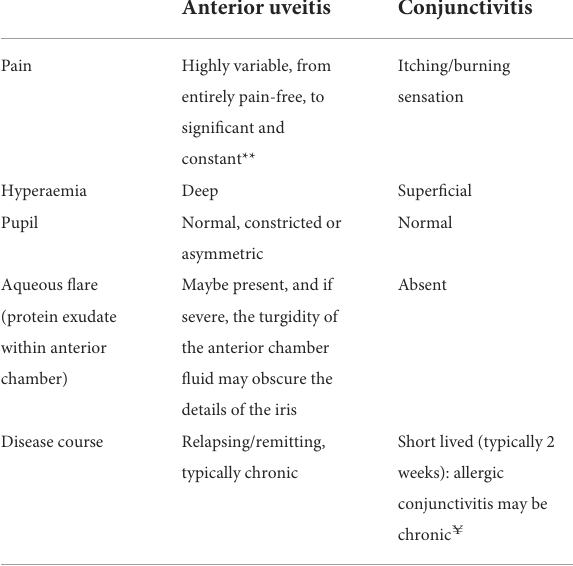
TABLE 1 Differentiating two key causes of the pediatric red eye * adapted from Gilani et al. (5). Anterior uveitis